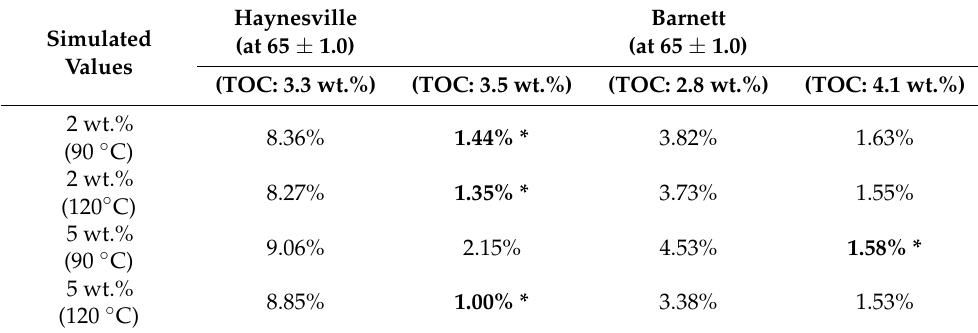
Table 4. Average Relative Error (%) analysis values of the adsorption isotherm values from simulation and experimental measurements.